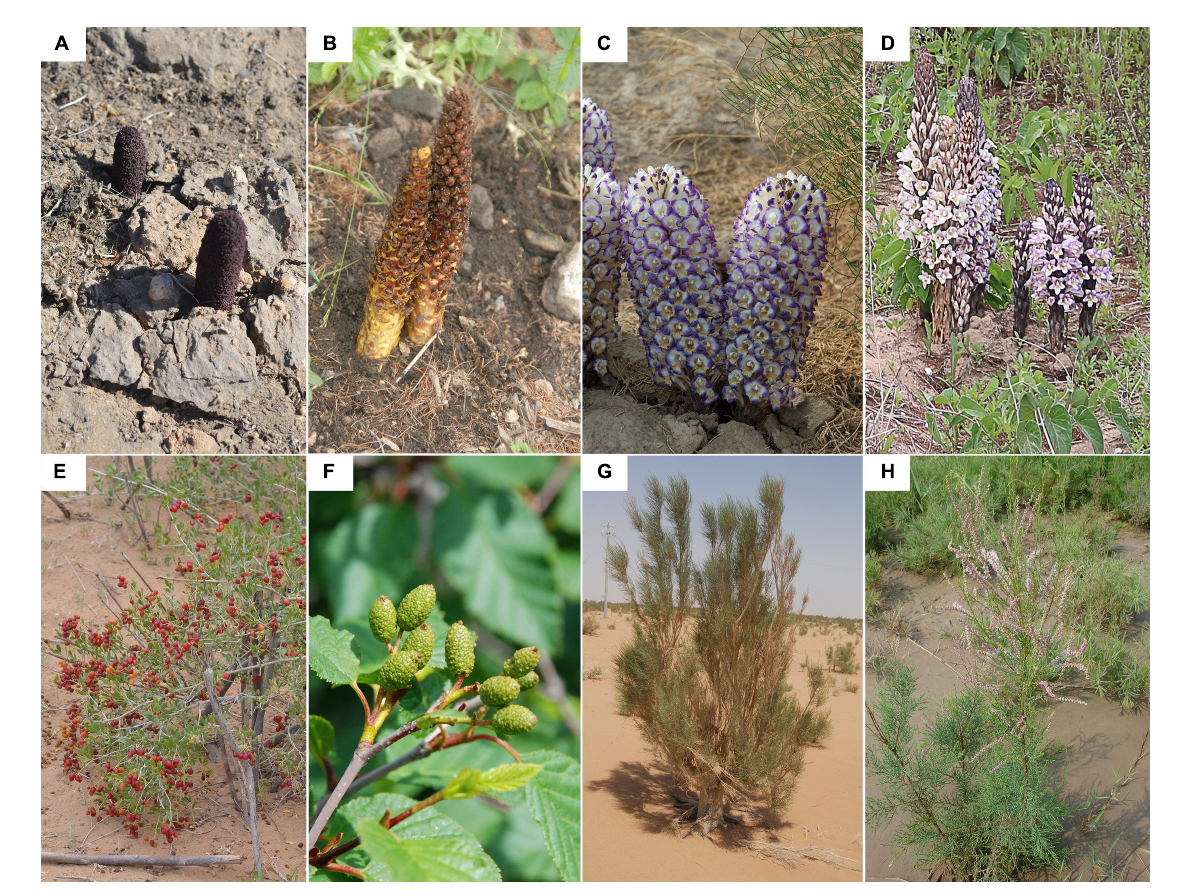
FIGURE1 The habitat and morphological features of four holoparasitic plants (A–D) and their primary hosts (E–H) . (A) Cynomorium songaricum ; (B) Boschniakia rossica ; (C) Cistanche deserticola ; (D) Cistanche mongolica ; (E) Nitraria sibirica ; (F) Alnus mandshurica ; (G) Haloxylon ammodendron ; (H) Tamarix ramosissima . The photographs (A,B,E) were provided by Liu L.; (C , D , G) by Duan S., Zang D., and Zhao D. respectively; (F,H) by Zhang G.